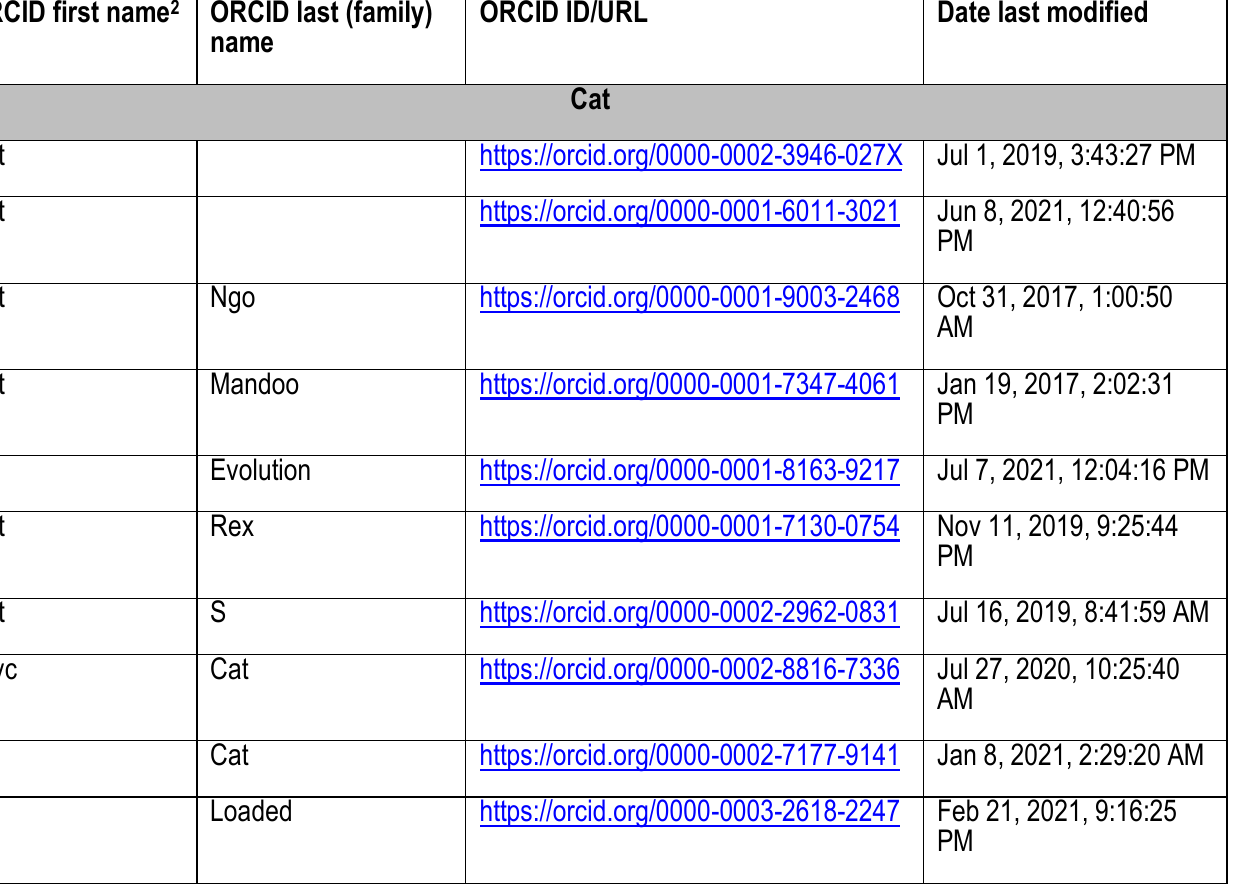
Table 1. Inspired on George Orwell’s Animal Farm [18], 24 examples of ORCID “researcher” accounts with identities associated with domesticated animals, none of which was associated with any academic